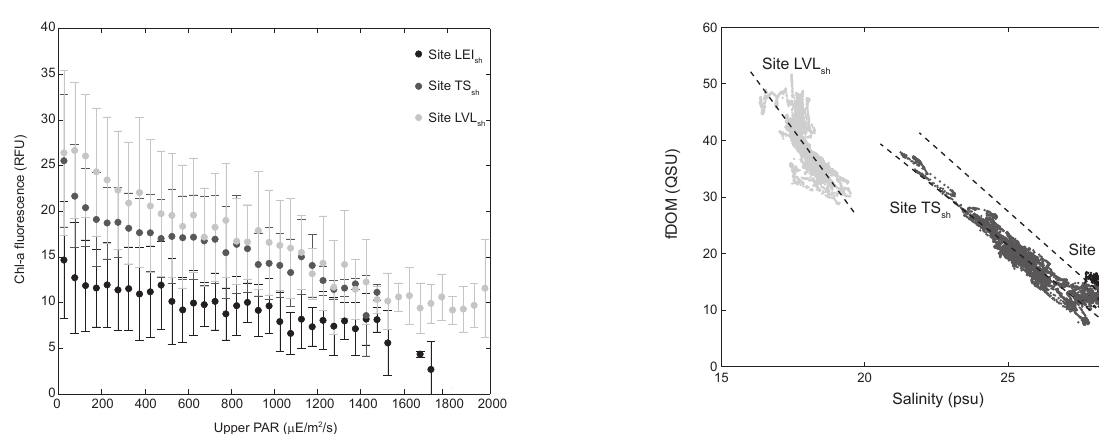
Figure 5. Relationship between binned near-surface irradiance in the PAR spectrum (400–700nm) and measured chlorophyll a fluo- rescence. Bounds are one standard deviation of measured fluores- cence within each bin. Fluorescence decreases with irradiance at all shoal sites, indicating substantial non-photochemical quenching (NPQ) of fluorescence.